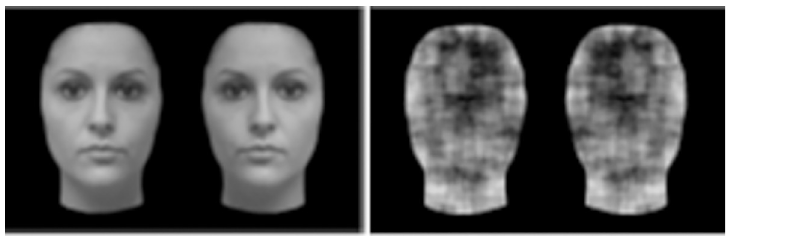
Fig 1. An example of faces (F), and their phase-scrambled versions